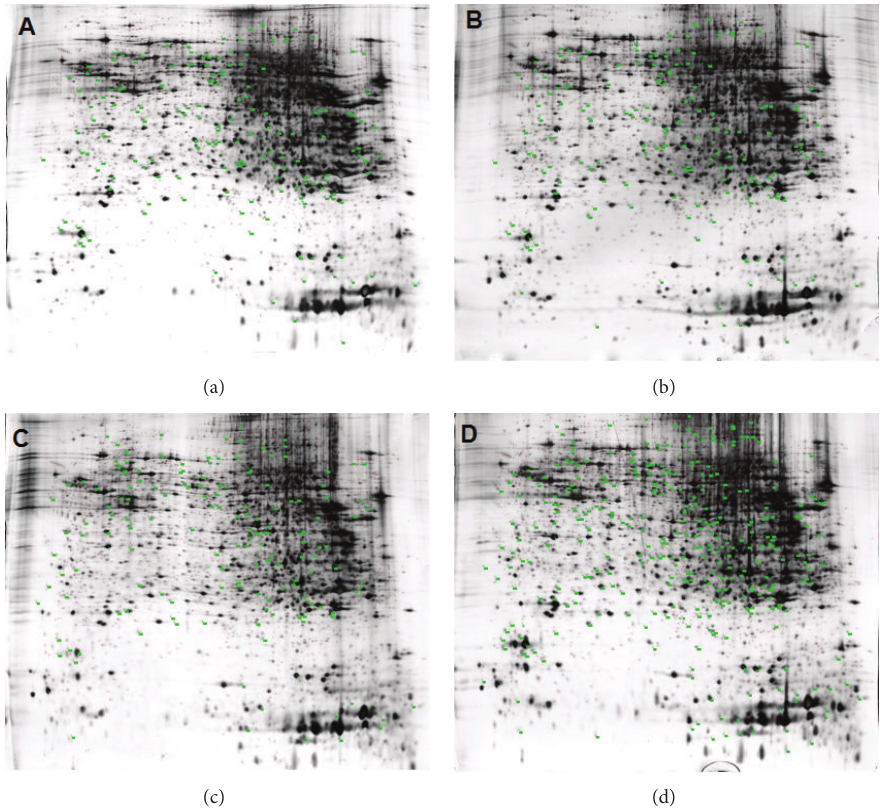
Figure 4: Differentially expressed protein spots displayed in 2DE images. Representative 2DE images from: (a) the ALD (4W) group, (b) the ALD (8W) group, (c) the ALD (12W) group, and (d) Anti-IL-17 antibody treated ALD group. Data are representative of three separate